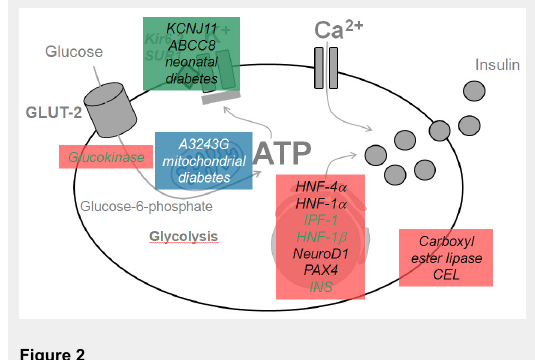
Pancreatic beta cell: the coupling of glucose sensing via GLUT-2 transporters, generation of ATP, membrane depolarization by closing potassium channels, entering of calcium ions, and exocytosis of insulin.